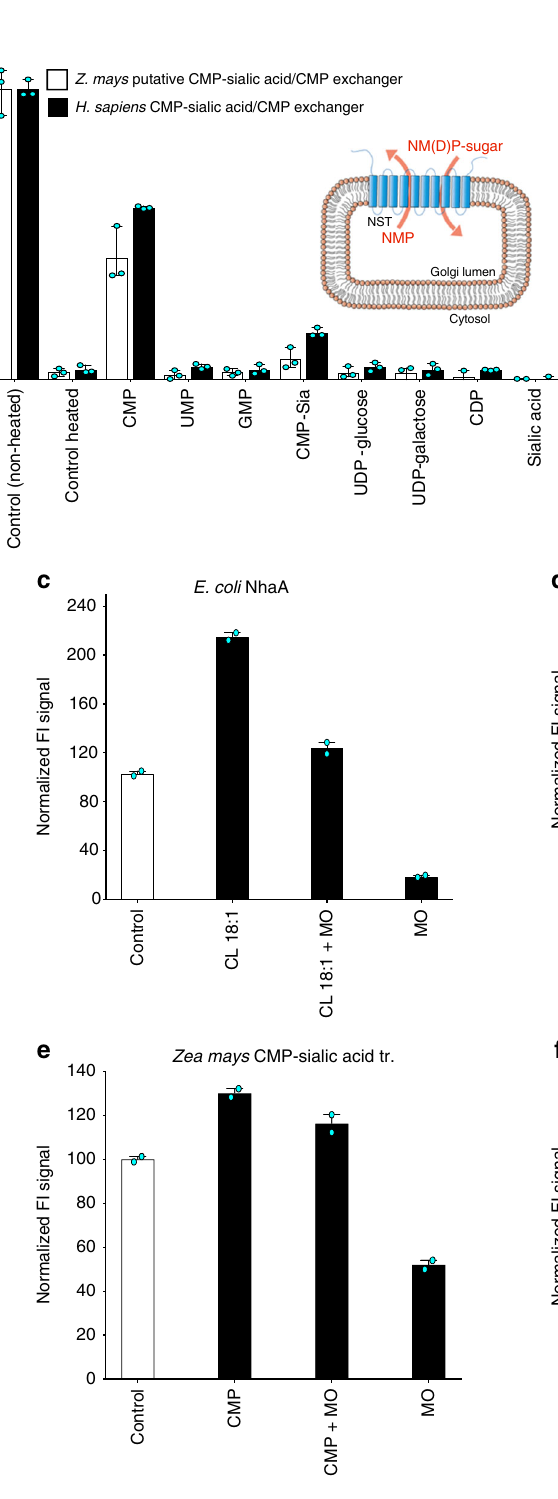
both bacterial and eukaryotic membrane proteins. Using FSEC- TS we are able to capture the speci fi c role of cardiolipin (18:1) in stabilizing the dimeric architecture of the sodium/proton anti- porter NhaA as was previously indicated by MS and MD simulations 14,15 . Sodium/proton antiporters are known to form dimers under physiological conditions 37 , and it has been shown that the dimeric form of NhaA is required for E. coli to grow under conditions of high-salt stress 18,38 . Considering that under high-salt conditions, where NhaA activity is upregulated 38 , the